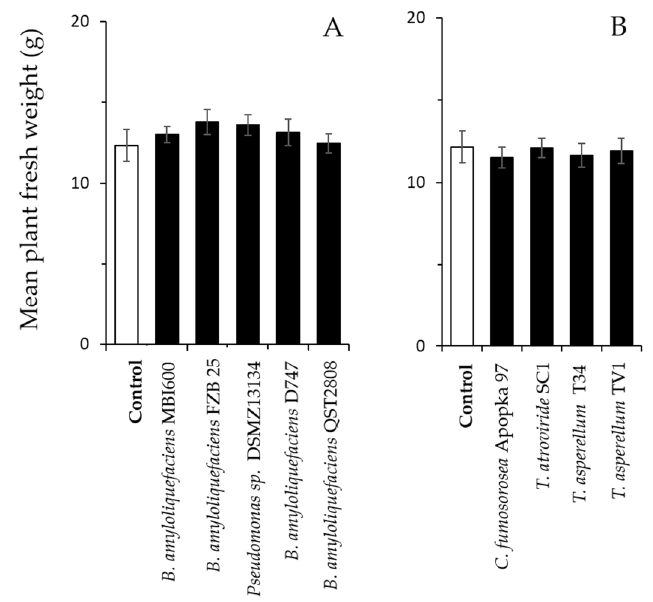
Figure 3. Effects of microbial colonization on plant growth of two-spotted spider mite-infested pepper. Plants were inoculated at transplantation and one week later with the different bacterial ( A ) and fungal ( B ) microbes. Shown are means (±SE) of fresh weight per plant ( n = 6 per treatment) 14 days following infestation with 45 adult T. urticae females per plant ( t -test; p > 0.05). Similarly, no significant effect was recorded in the fresh weight of plants that were inoculated with the tested microbes and infested with 10 aphids for 14 days compared with the control plants (Figure 4A; bacteria: − 1.56 ≤ t ≤ 0.46, df = 10, 0.148 ≤ p ≤ 0.651; Figure 4B; fungi: − 0.71 ≤ t ≤ 0.489, df = 10, 0.496 ≤ p ≤ 0.837).